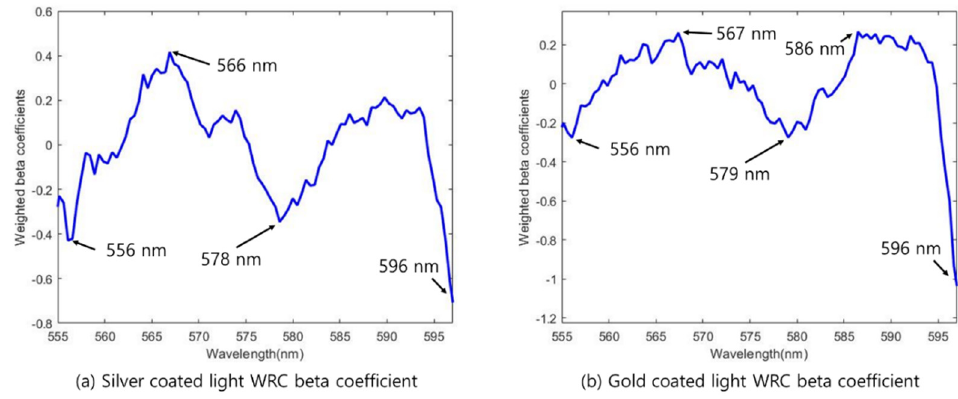
Figure 10. Selected bands using the WRC method: ( a ) silver − coated light WRC; ( b ) gold − coated light WRC.